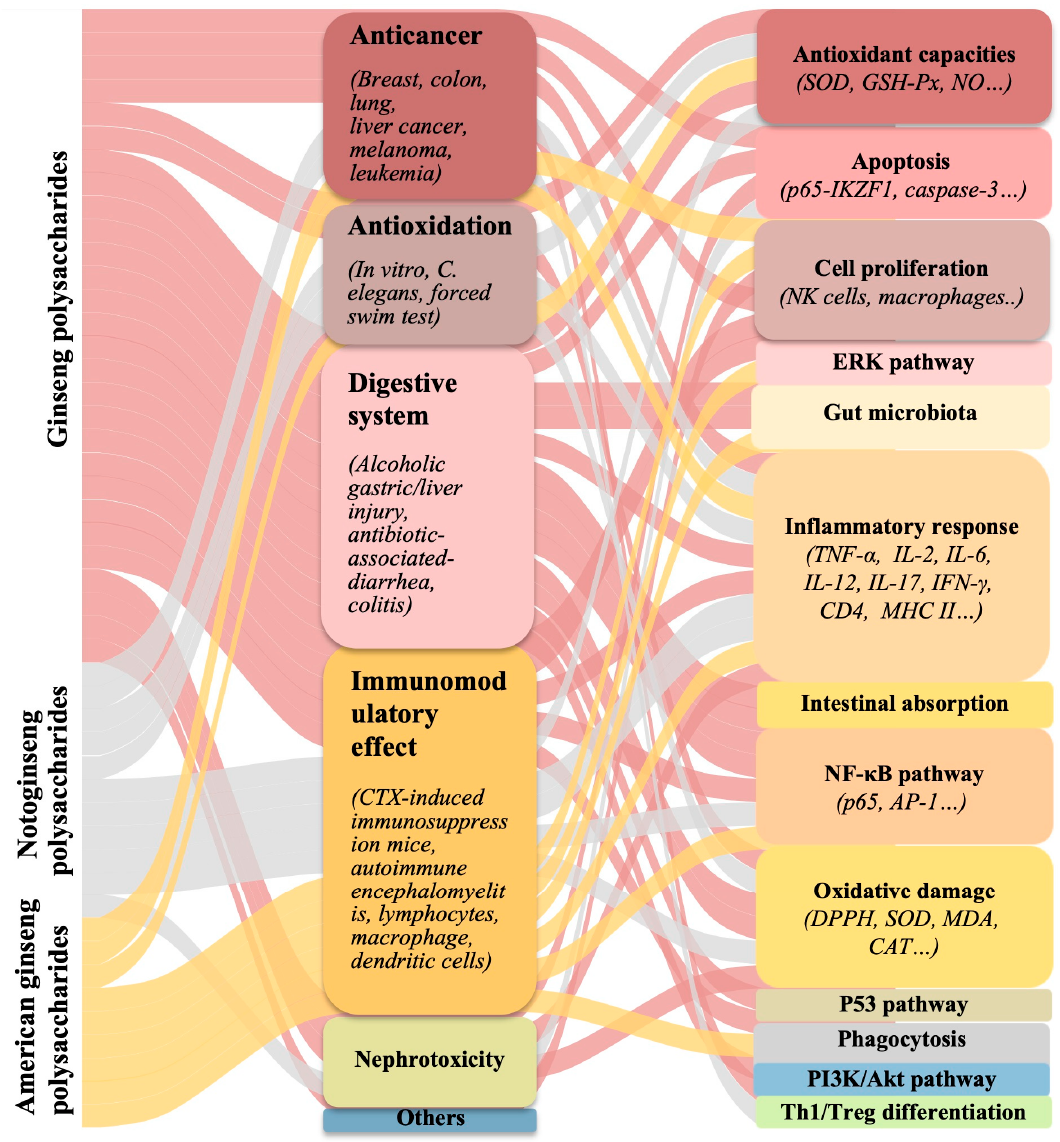
Figure 2. Summary for biological activities and molecular mechanisms of the polysaccharides from three species against multiple